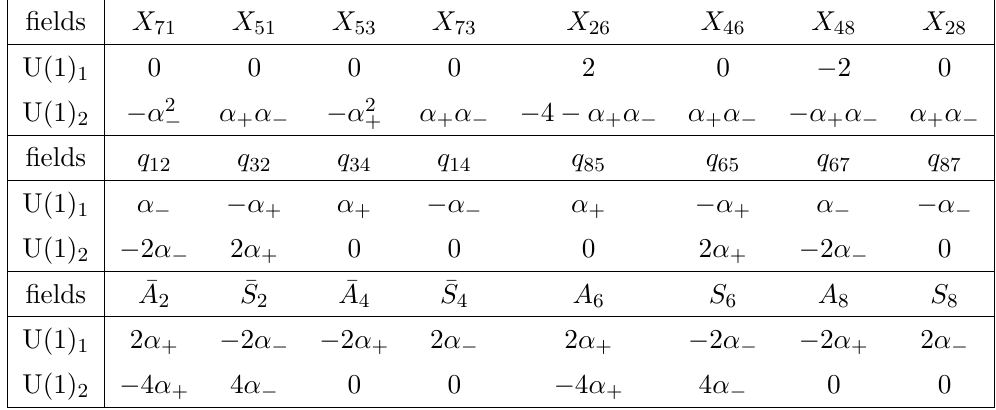
Table 2 . Charge assignment of the (cid:12)elds in the quiver gauge theory of (cid:12)gure 2. Here, (cid:11) (cid:6) = N (cid:0) 1